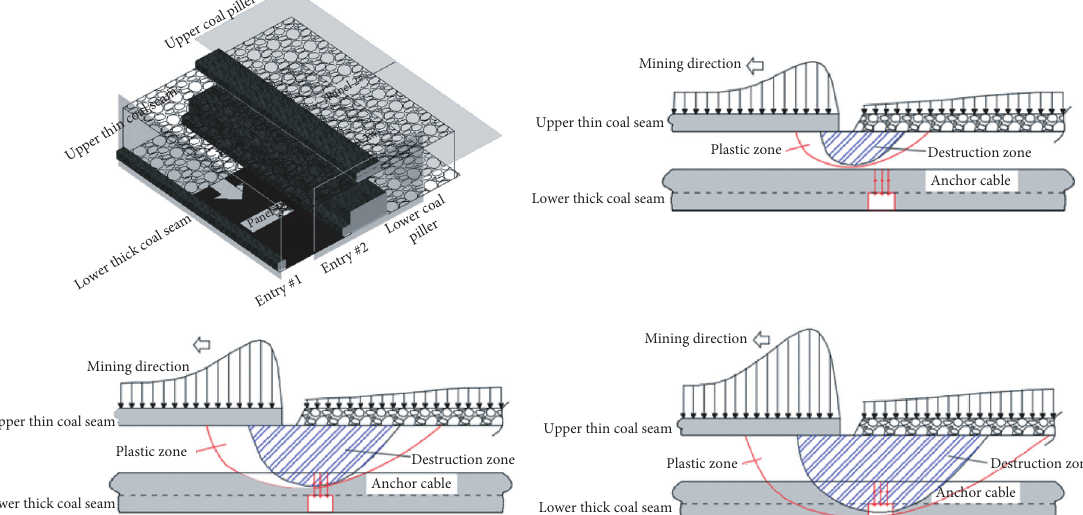
Figure 1: Influence of mining in upper coal seam on damage to the lower coal